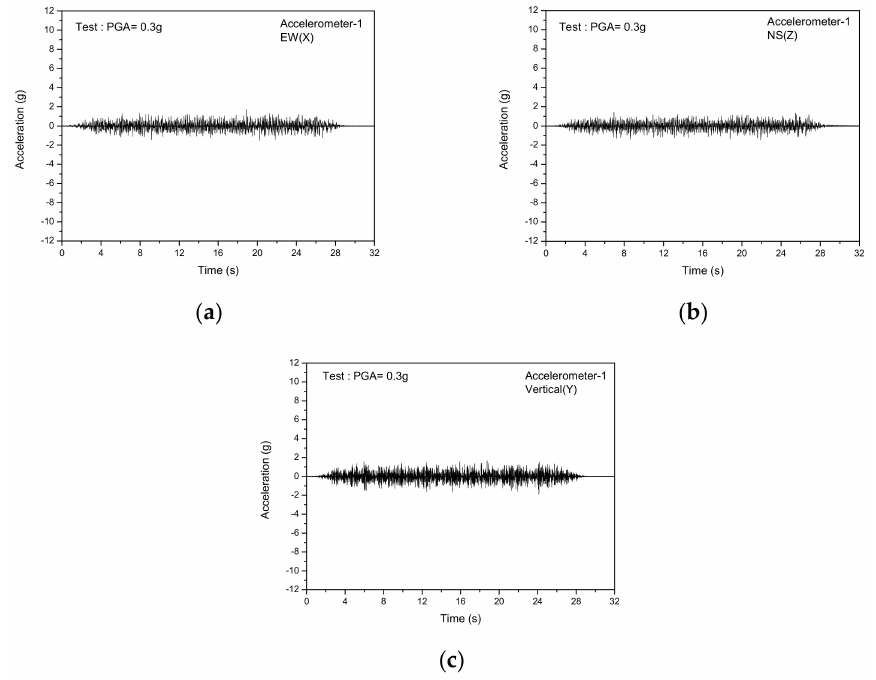
Figure 10. Test results of acceleration responses at the shaking table for PGA = 0.3 g: ( a ) EW (X); ( b ) NS (Z); ( c ) V (Y).